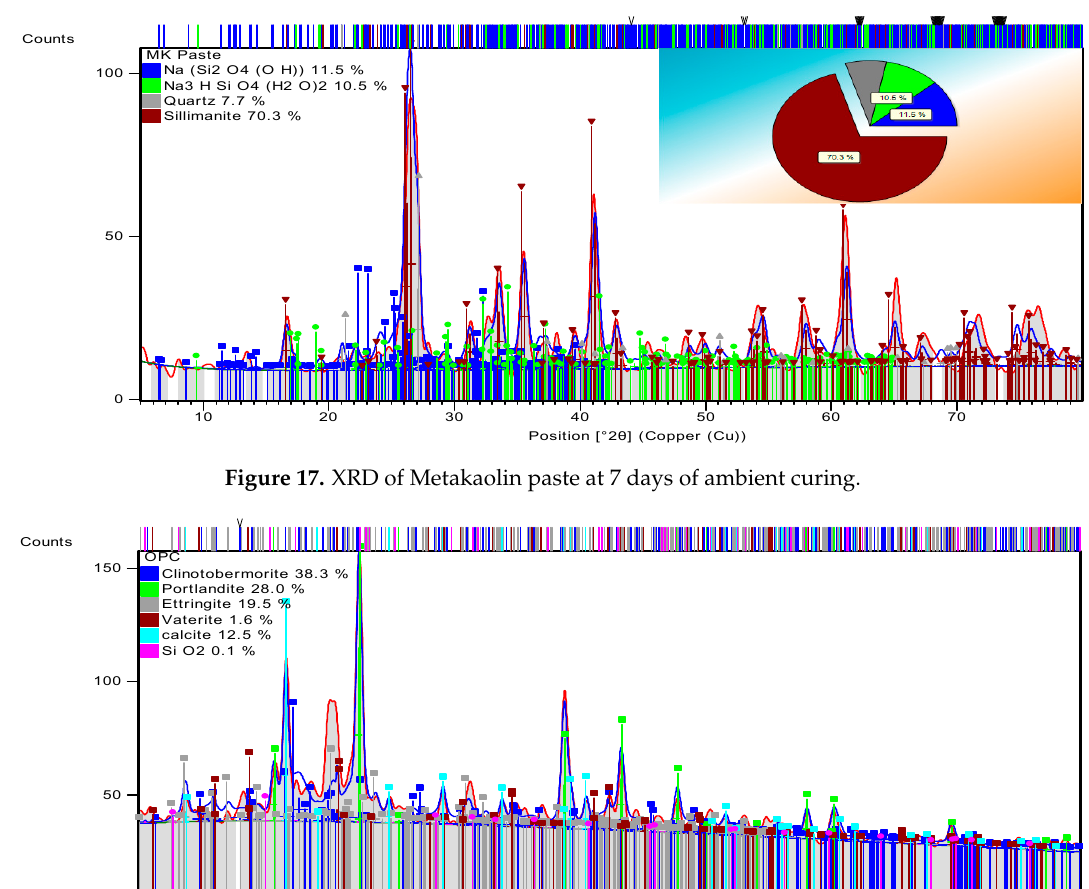
C-S-H C-A-S-H N-A-S-H (C, N)-ASH Figure 19. Molecular structure of C-S-H, C-A-S-H, N-A-S-H, and C, N-ASH. 3.3.4. Alkali-Activated FA, GGBS and MK Studied Using FTIR Fourier transform infrared spectroscopy (FTIR) was performed to fi nd the chemical bond present in the low-calcium and high-calcium paste cured at seven days. FTIR spectra of the low calcium (FA and MK) and high calcium (GGBS and OPC) paste are shown in Figure 20. The presence of various chemical bonds in the pastes included H-OH (bending and stretching band), OCO (absorption band), TOT (T: tetrahedral Si or Al), and Si-O-Si bonds. In FA, GGBS, MK, and OPC, the H-OH water bond is observed at the intensities of 3615, 3634, 3610, and 3336 cm − 1 , respectively. The structural water bond is noticed at 1664, 1671, and 1659 cm − 1 for FA, GGBS, and OPC, respectively, while there is no structural wa- ter bond in the MK [71].